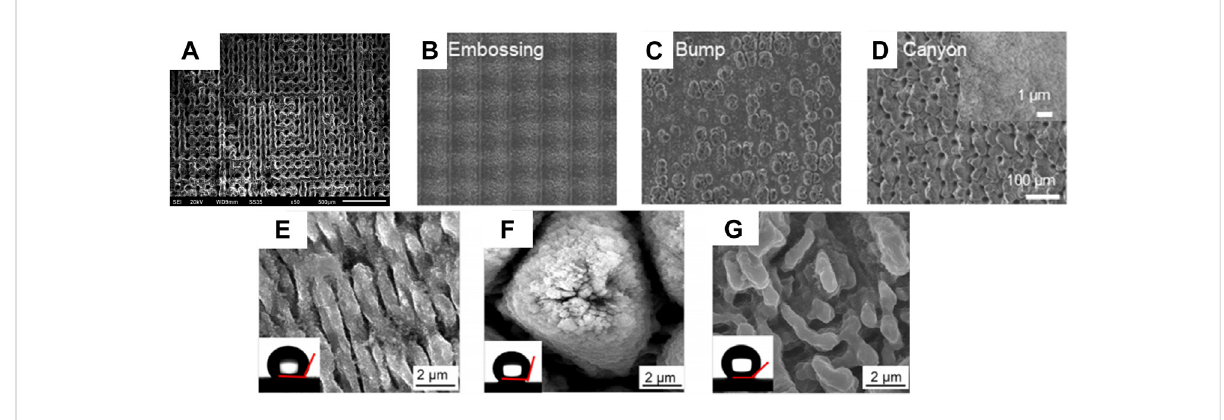
FIGURE 6 SEM images of laser textured surface from (A) (Aulakh and Kushal, 2019), (B – D) (Park et al., 2018), and (E – G) (Zhang et al.,